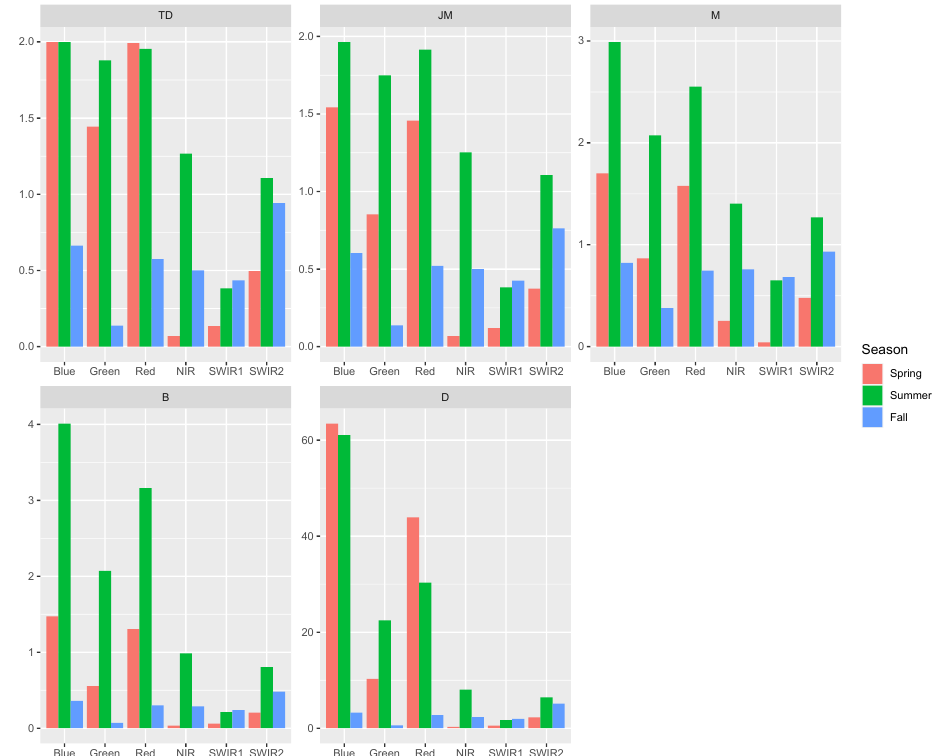
Figure 5. Seasonal spectral separability metric results between western snowberry and wolfwillow across selected Landsat 8 bands (Transformed Divergence (TD), Jeffries–Matusita (JM) distance, M-Statistic (M), Bhattacharyya distance (B), Divergence (D)).